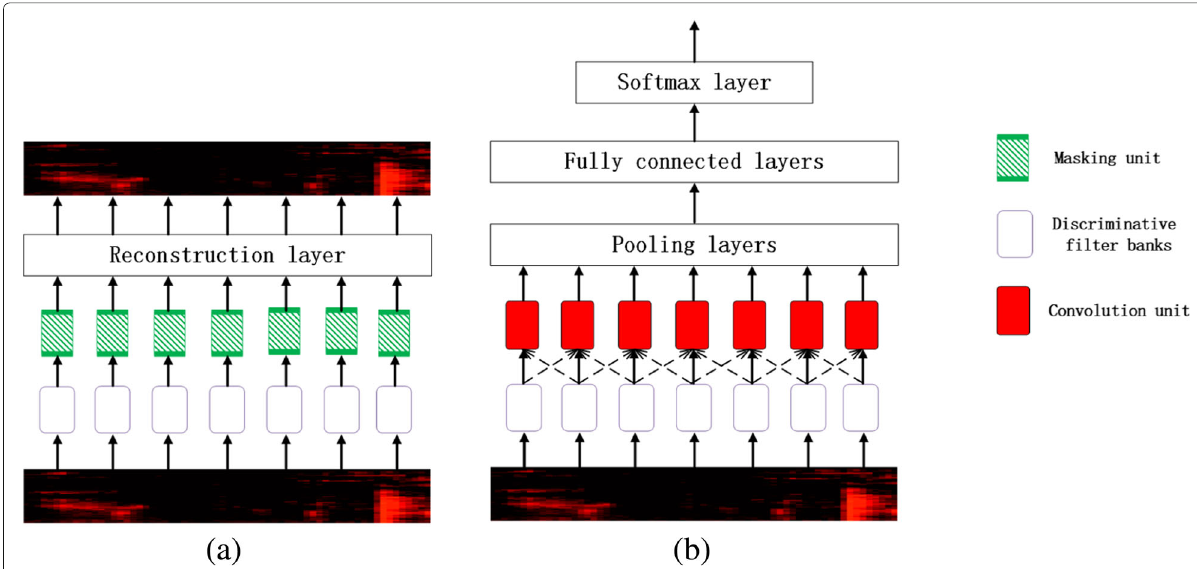
Fig. 4 NN-based structures with proposed methods. a is the NN structure for audio source separation tasks. b is the NN structure for audio scene classification